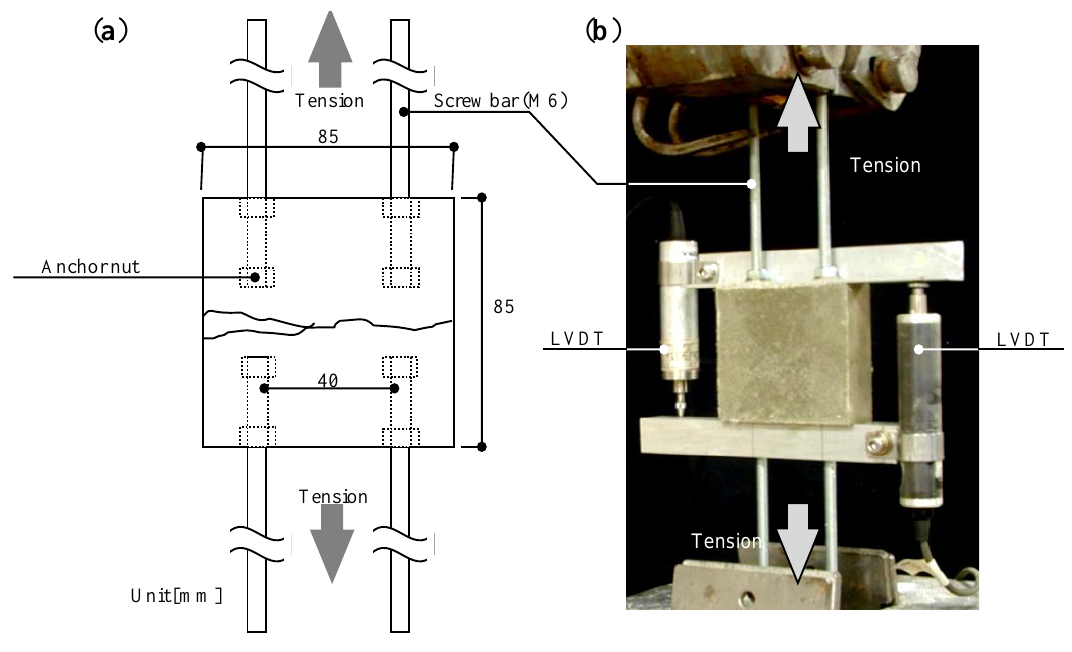
Figure 3. ( a ) Geometry of specimen and ( b ) direction of load during tensile